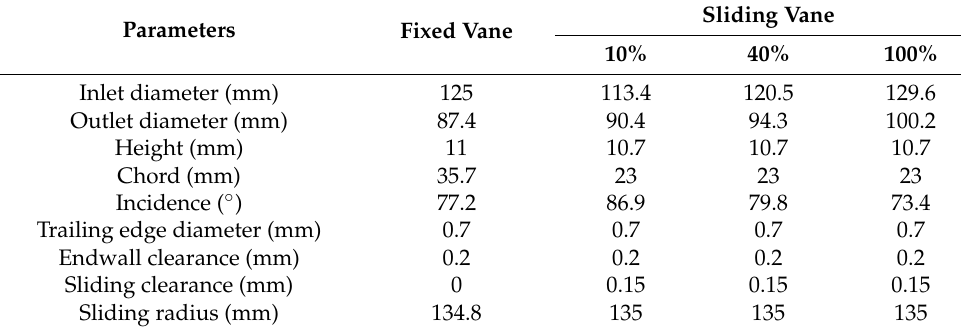
Table 2. Geometric parameters of the SSGV at different opening